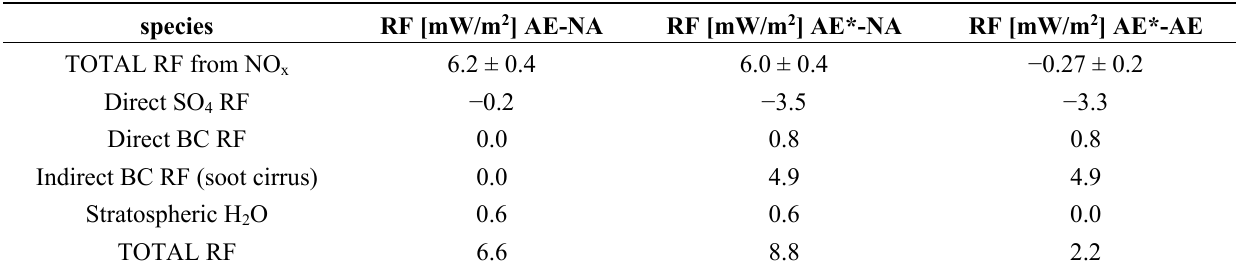
Table 8. Summary of Radiative Forcing (RF) mean values relevant for aviation emissions, excluding CO 2 , contrails and contrail-cirrus, which are not explicitly considered in the present study. RF values from NO x are obtained as a mean from the CTMs (ULAQ, CTM2 and CTM3) and Oslo and ULAQ radiative code calculations. The uncertainty interval is calculated as the range of the net NO x -related RF from the three